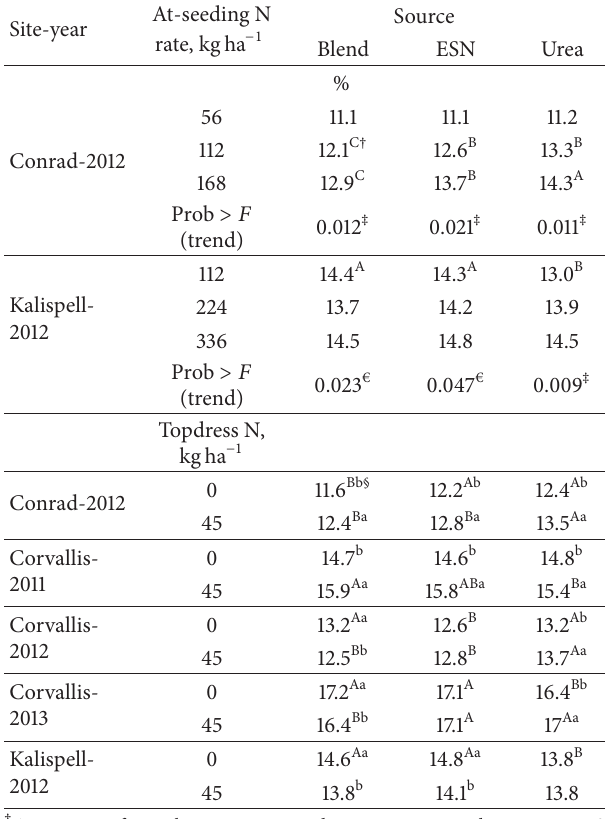
† Across rows for each site-year, at-seeding N rate, or topdress N rate, LS means followed by different uppercase letters are significant at 𝑝 < 0.05 . ‡ & € represent significant linear and quadratic trends, for at-seeding N rate for each source. § Down a column for topdress N rates, LS means followed by different lowercase letters are significant at 𝑝 < 0.05 for each